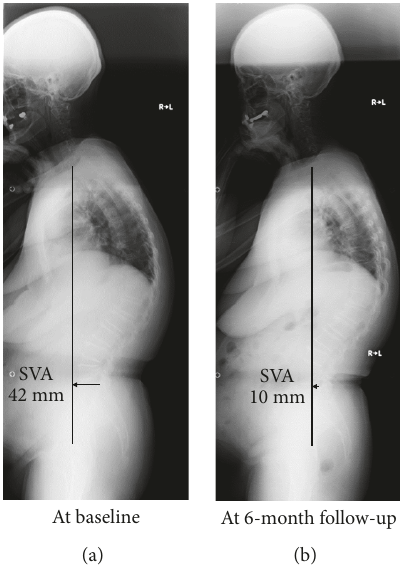
Figure 1: A 70-year-old woman with “locomotive syndrome risk level 2” from lumbar spondylosis. Standing whole-spine radiographs showed the sagittal vertical axis (SVA) of 42mm with thoracic kyphosis (a). After our 6-month “locomotion training” outpatient rehabilitation program, she showed the improvement to “locomotive syndrome risk level 1” with the improved SVA up to 10 mm ( < 40mm, normal range) and decreased thoracic kyphosis in radiographs